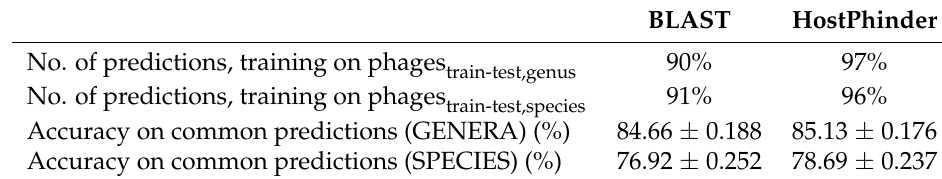
Table 4. HostPhinder and BLAST performance comparison on the phages